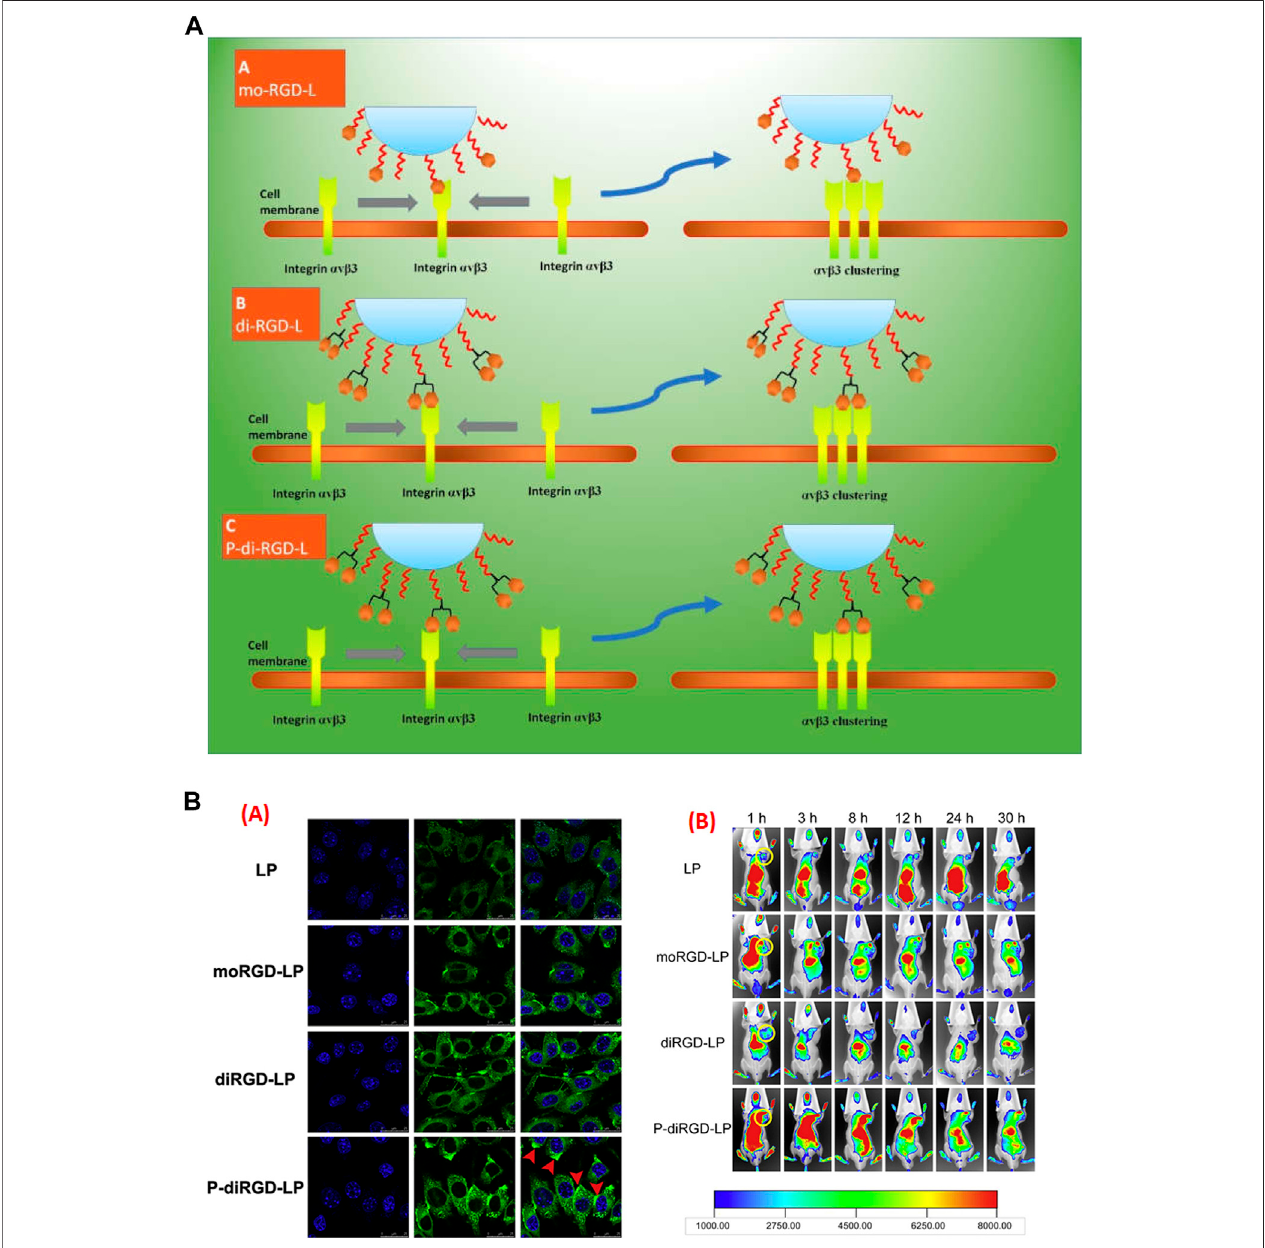
FIGURE 4 | (A) Schematic demonstration of different RGD modi fi ed nanocarrier towards the adjacent binding site of α v β 3 integrin. In fi rst case, mo-RGD-L molecules, the RGD moietywere too distant tobind with two α v β 3clusteringelements,in second case with di-RGD-L, thetwo RGD motifs werevery near to each other and thus conformationally unrelated to two α v β 3 clustering elements, while P-di-RGD-L were appropriate to bind ef fi ciently to the two integrin cluster elements. (B) (i) Confocallasermicroscopicimages(CLSM)ofmelanomacells(B16)incubatedat37 ° C,pre-incubatedwithrespectedpreparations, (ii) Invivo fl